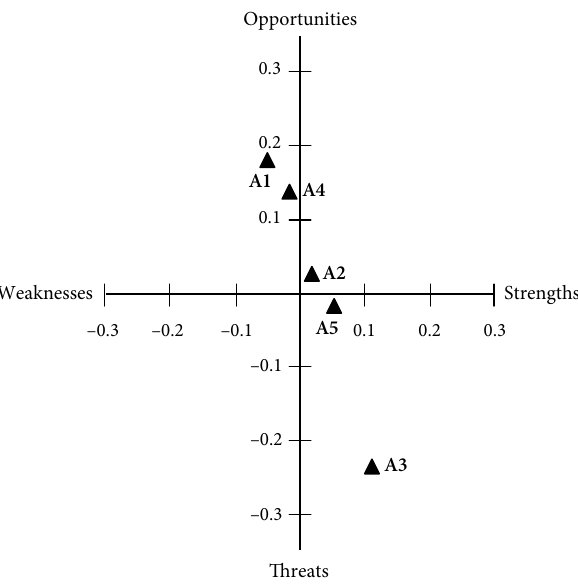
Fig. 5. The matrix of the 2 nd -tier city in China based on FAHP